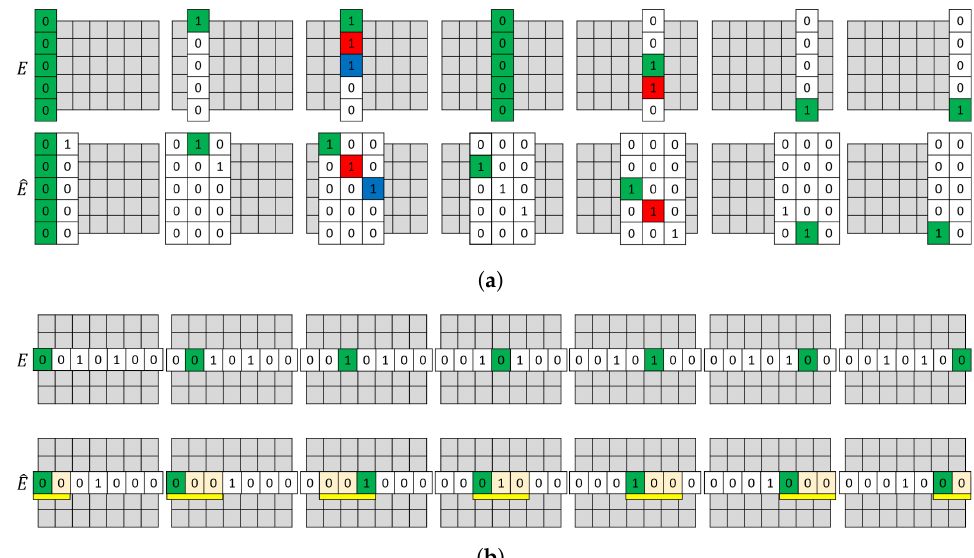
Figure 4. Algorithms 1 and 2 execution examples. ( a ) Algorithm 1 execution example for SAS. Colors show the algorithm’s matching. Note that Col 1 ( E ) = θ and it is matched with Col 1 ( ˆ E ) = θ . However, Col 4 ( E ) = θ is inevitably matched with sensor m 2 from Col 3 ( ˆ E ) ( b ) Algorithm 2 execution example for TSR. The yellow ribbon shows the window time frame and green shows the algorithm’s